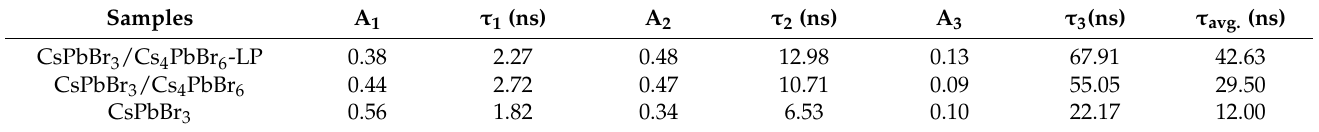
Table 1. Fitted lifetimes of the CsPbBr 3 , CsPbBr 3 /Cs 4 PbBr 6 , and CsPbBr 3 /Cs 4 PbBr 6